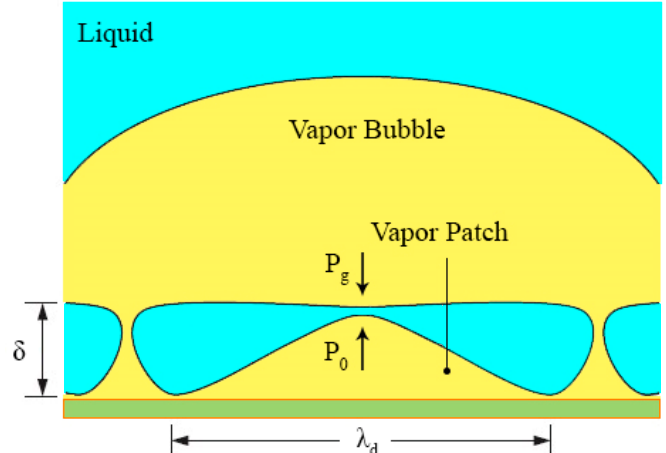
Figure 21. Macrolayer lift-off illustration during CHF from a horizontal upward-facing surface [271]. Reproduced from [271], Elsevier: 2011.